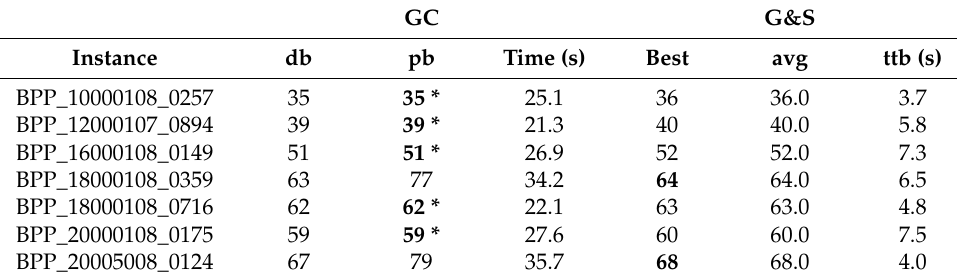
Table 3. Results for the set of instances of class